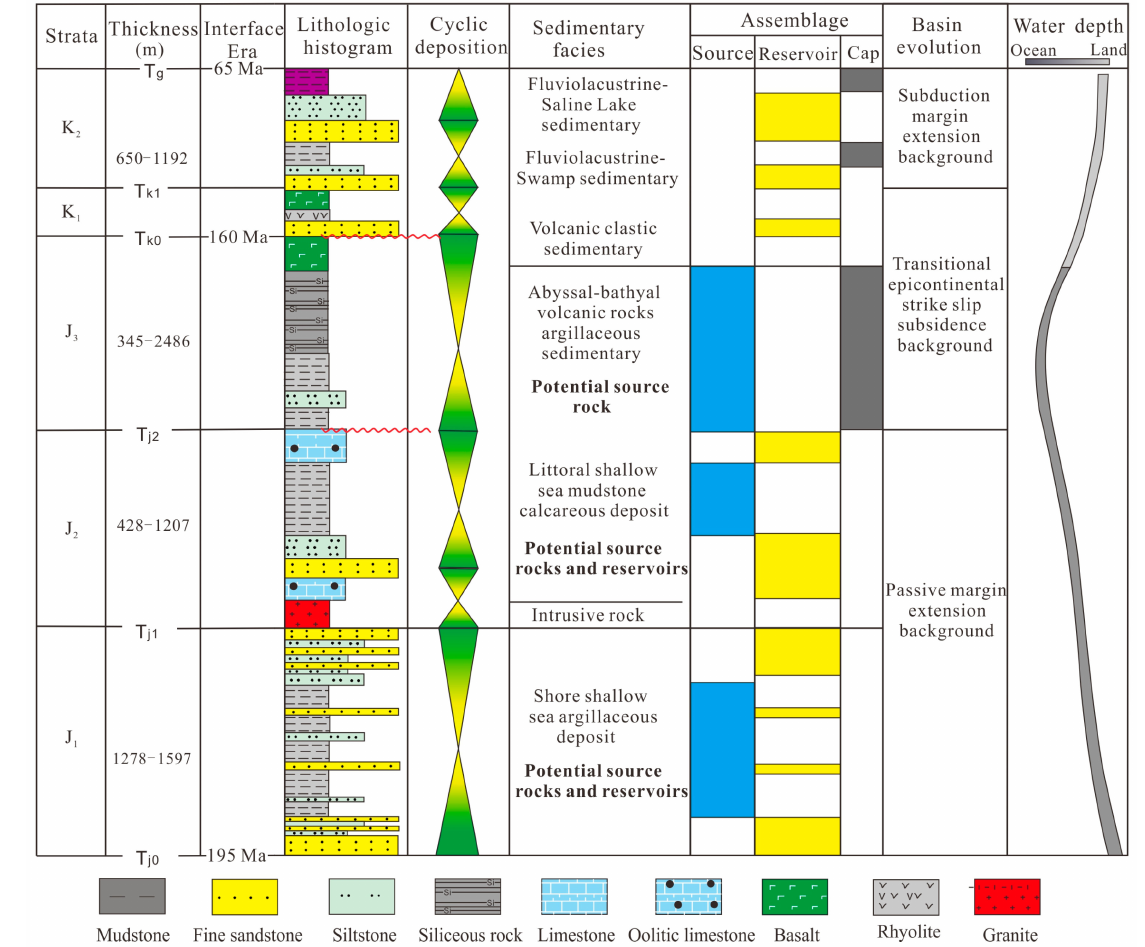
Figure 11. Comprehensive histogram of Chaoshan depression